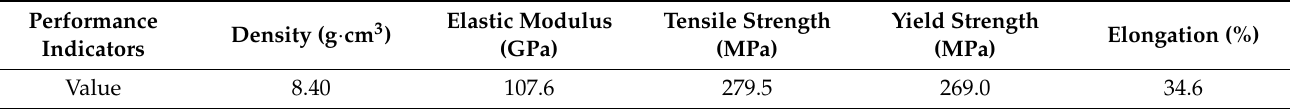
Table 3. Performance parameters of copper tube.